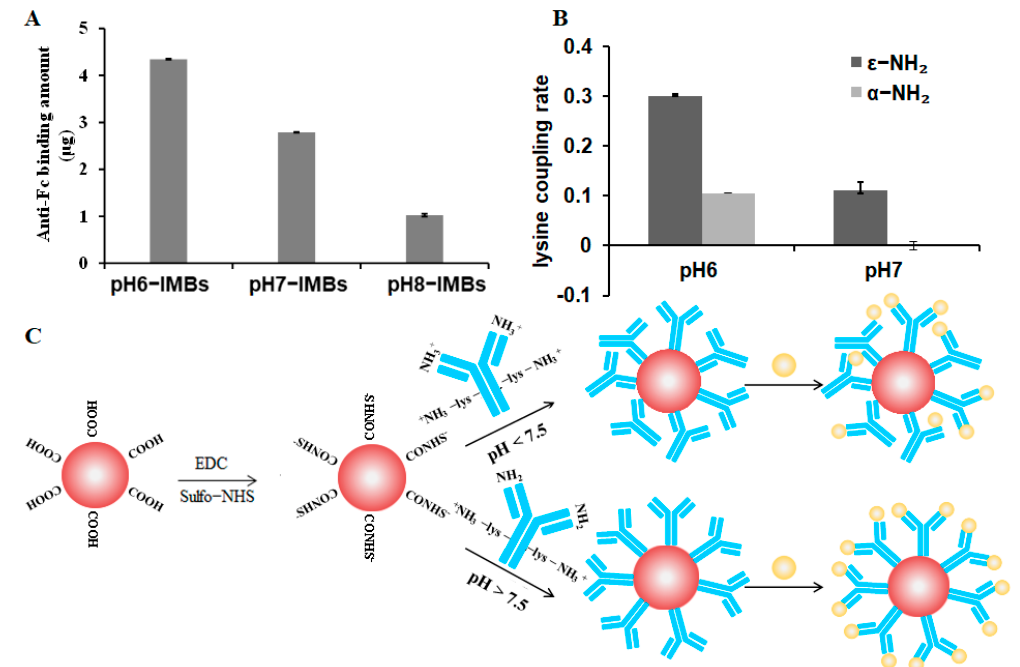
Figure 6. Mechanism of antibody orientation. ( A ) Amount of anti − Fc antibody bound to IMBs, ( B ) The coupling ratio assay of α− NH 2 − lys and ε− NH 2 − lys at pH 6.0 and 7.0, ( C ) The proposed mechanism of antibody orientation on MBs for S. aureus. Red spheres represent MBs, yellow spheres represent S. aureus, and blue stick structures represent antibody.